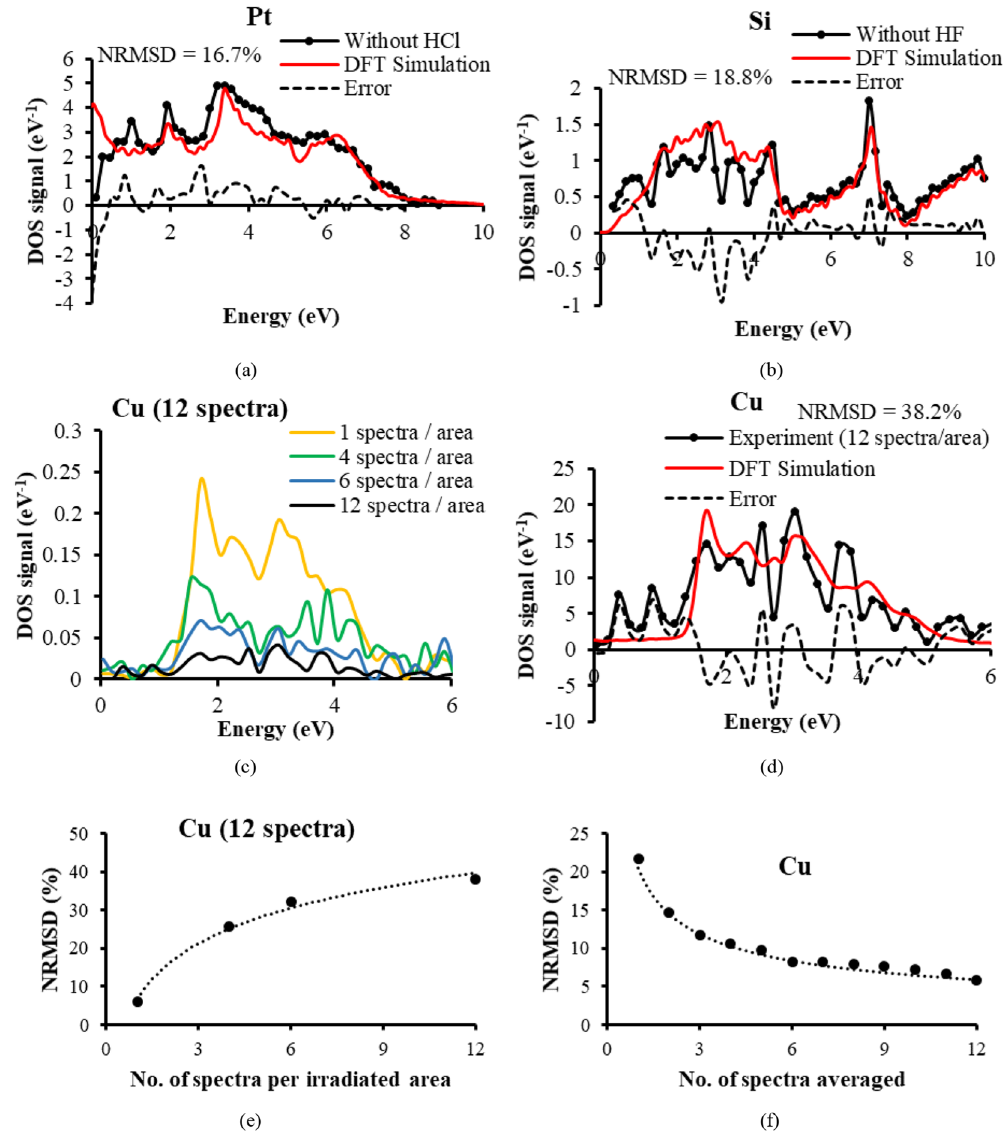
Figure 1. A correct version of the original Figure